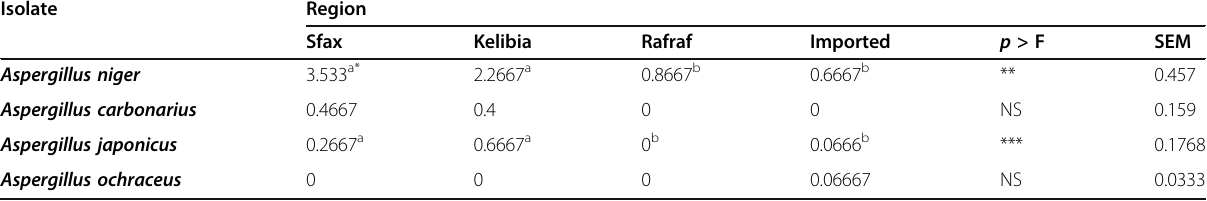
Table 1 Effect of the sample origin on the mean distribution of the different ochratoxigenic species Isolate